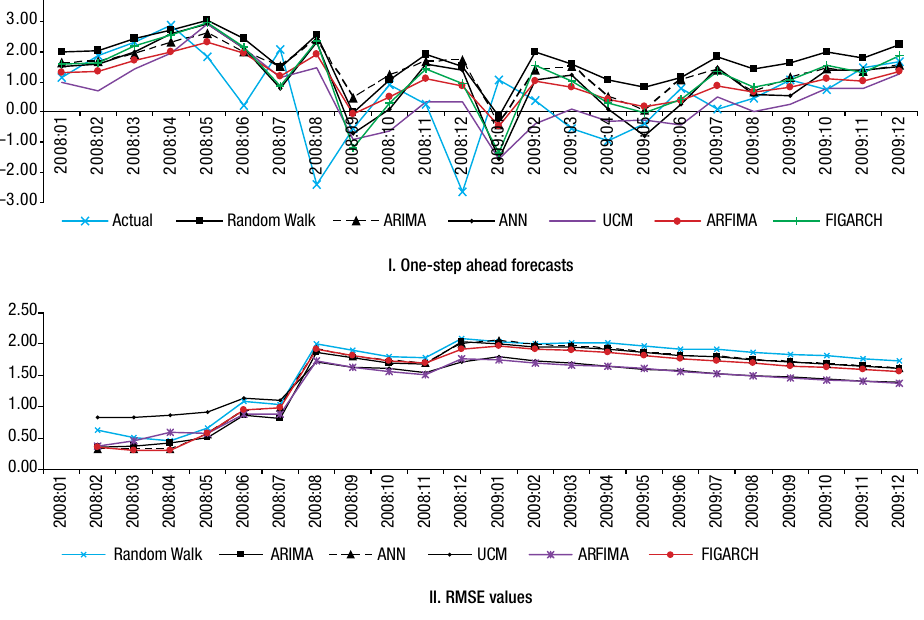
II. RMSE Fig. 3. Out of sample one-step forecasts and RMSE values of the alternative models